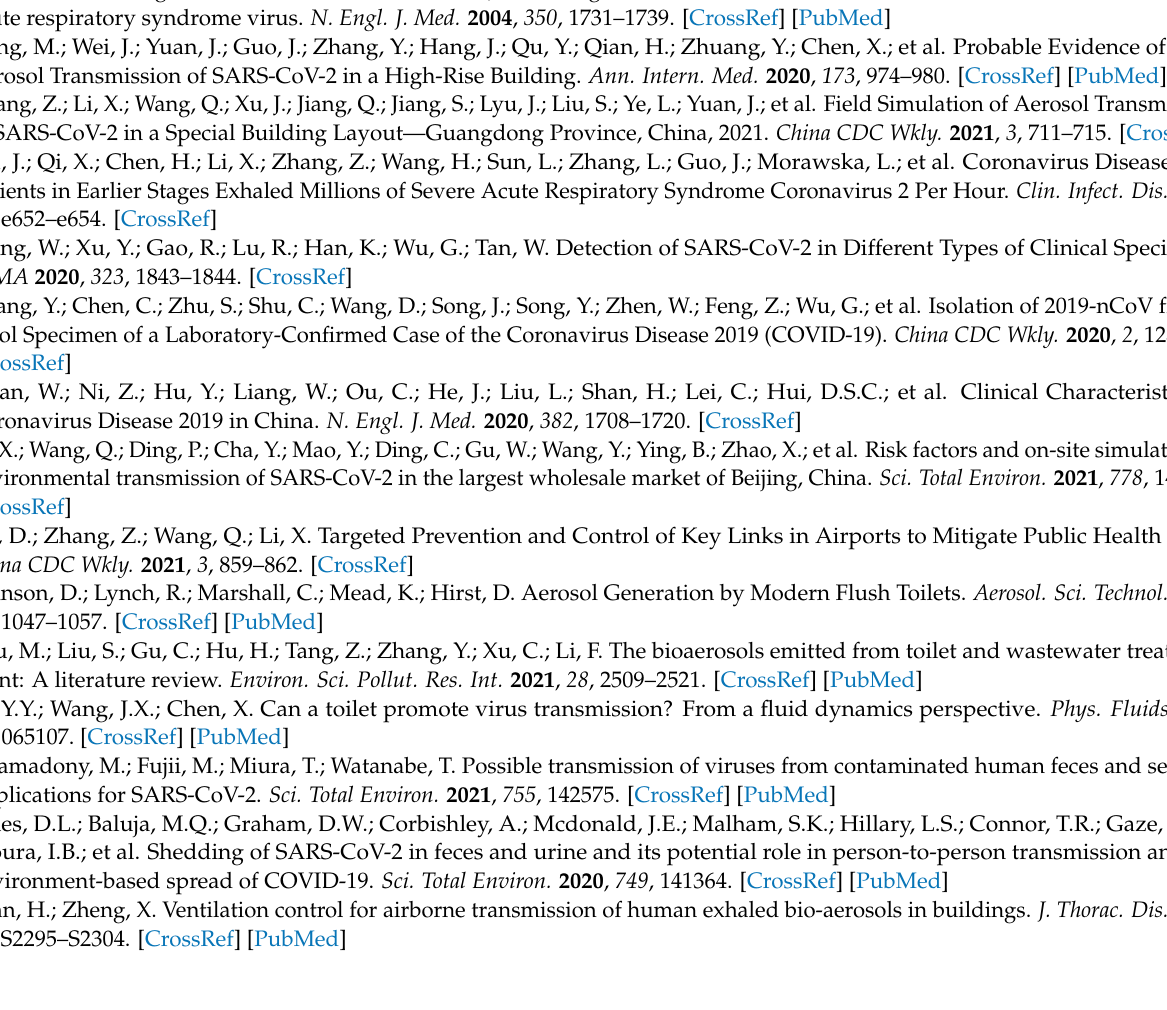
respiration simulation. Figure S4: Representative photos of fluorescent microspheres tracked by different sampling methods in different